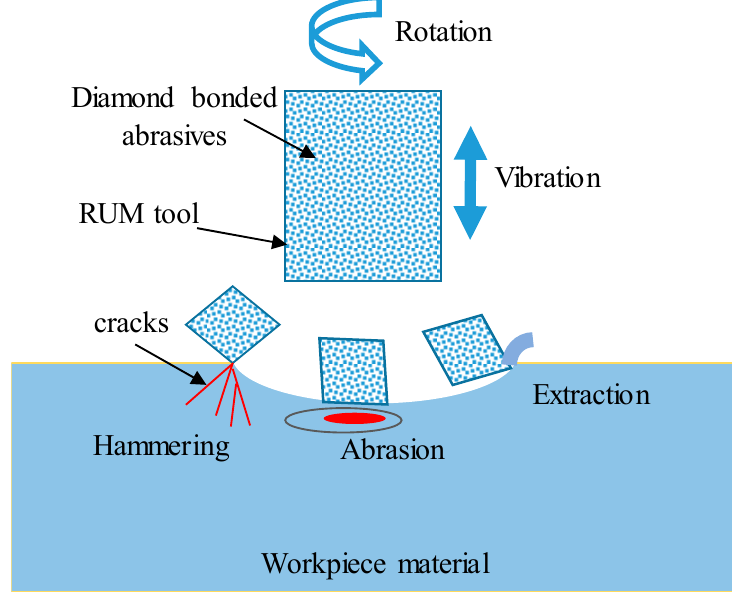
Figure 1. Mechanism of material removal of rotary ultrasonic machining (RUM).